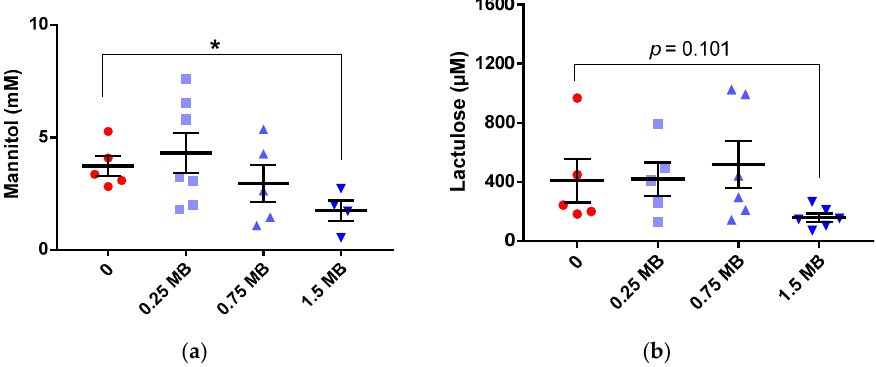
Figure 3. Urinary concentrations of mannitol and lactulose in rats fed a high-fat control diet with butter (0), or the same diet supplemented with 0.25 MB g/100 g (dry weight basis) (0.25 MB), 0.75 MB g/100 g (0.75 MB), or 1.5 MB g/100 g (1.5 MB) for 3 weeks. ( a ) Mannitol (mM, p < 0.05), ( b ) lactulose (µM). Values are means ± SEM. Mean values were significantly different from the control group: * p < 0.05 (unpaired, 2-tailed t -test). Missing data points were due to unexpectedly broken urine collecting tubes and values below detection limit. MB, monobutyrin.